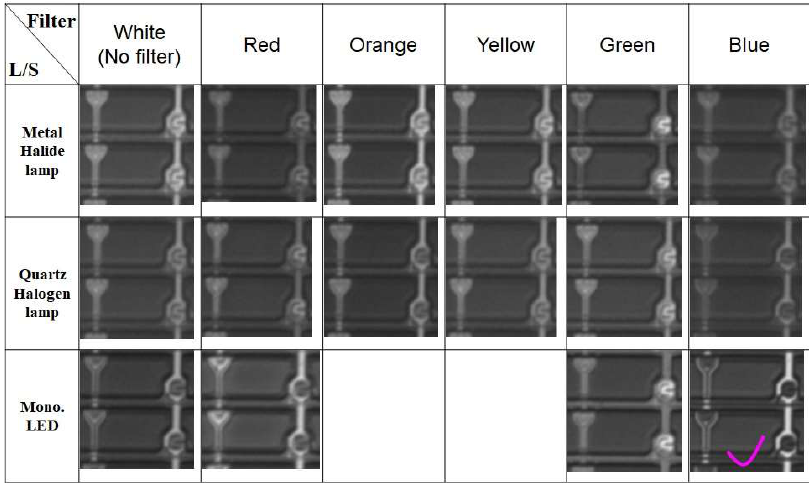
Figure 6. The fourth layer circuit pixel by various lamps for optical detection in TFT.